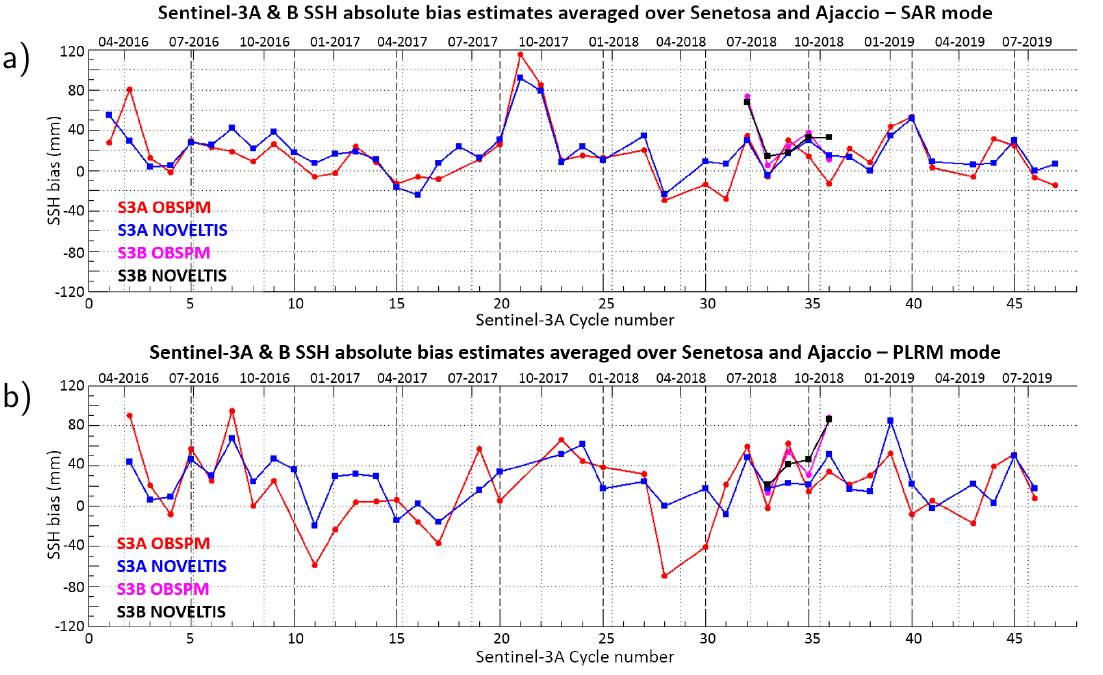
Figure 25. Sentinel-3A and Sentinel-3B absolute SSH bias estimates on track 741, averaged over the Senetosa and Ajaccio sites for ( a ) SAR mode and ( b ) PLRM data, obtained with the two processing methods (OBSPM and